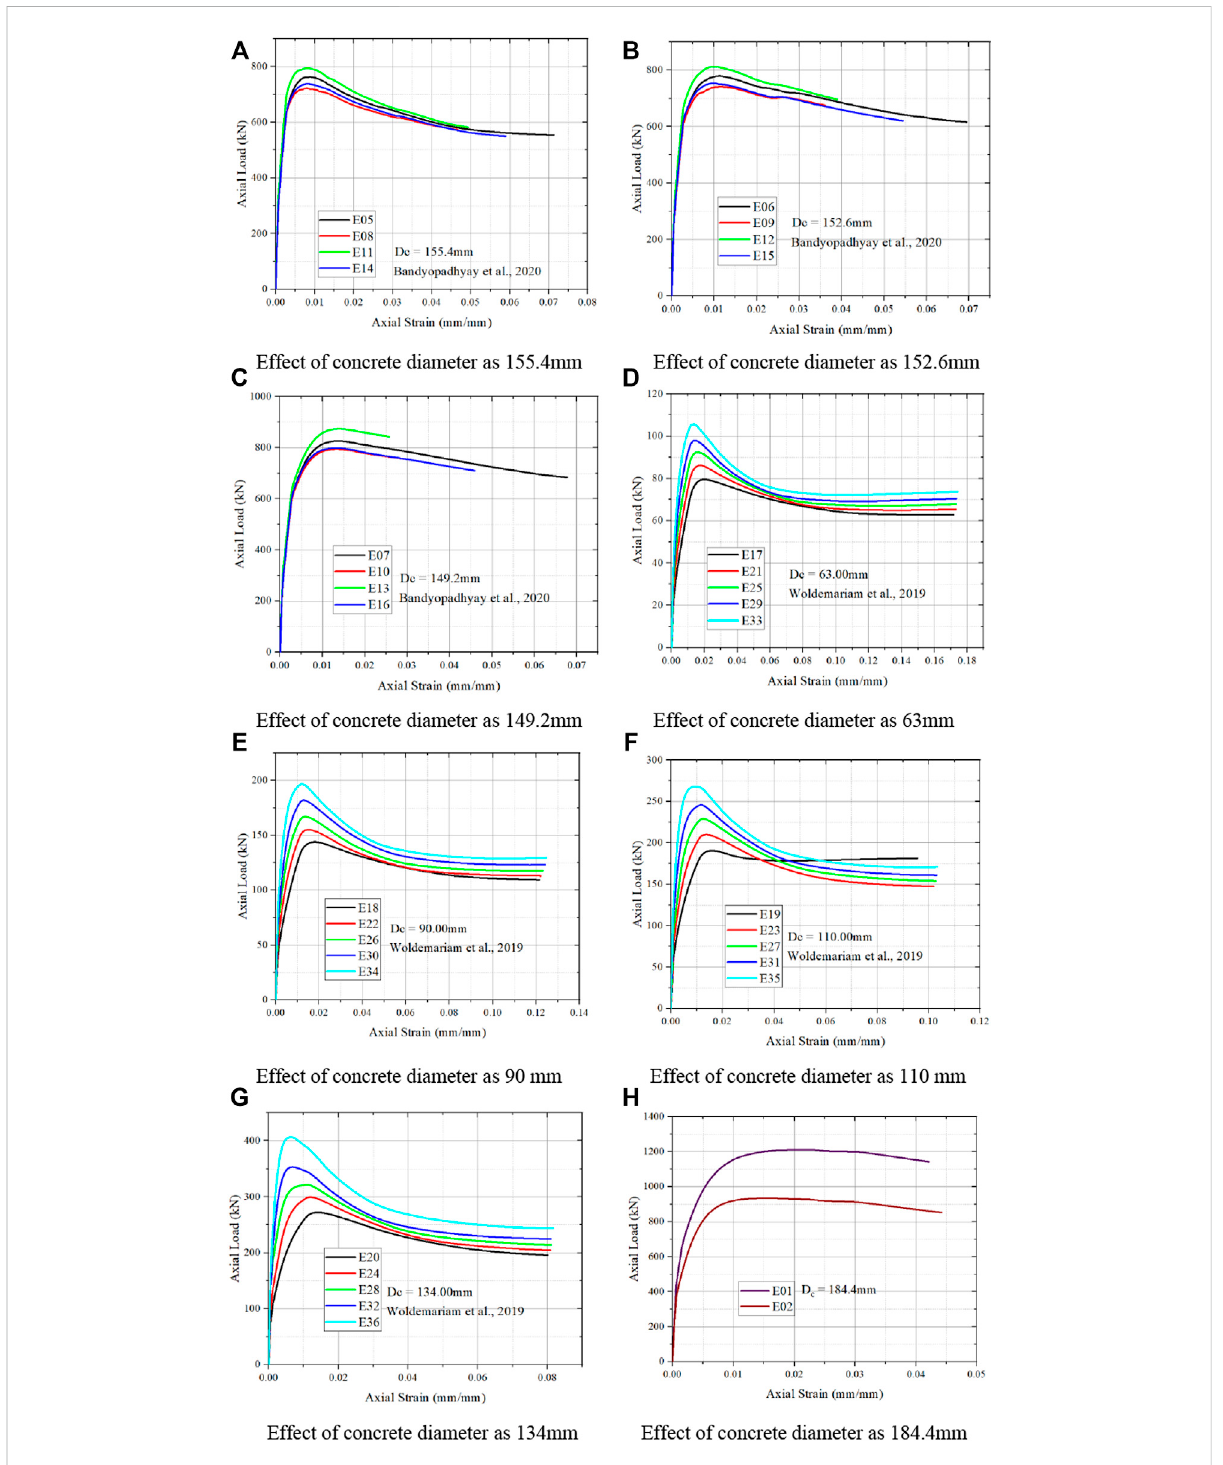
FIGURE 12 Effect of specimen diameter on strain and load carrying capacity of CFPT columns. (A) Effect of concrete diameter as 155.4 mm. (B) Effect of concrete diameter as 152.6 mm. (C) Effect of concrete diameter as 149.2 mm. (D) Effect of concrete diameter as 63 mm. (E) Effect of concrete diameter as 90 mm. (F) Effect of concrete diameter as 110 mm. (G) Effect of concrete diameter as 134 mm. (H) Effect of concrete diameter as 184.4